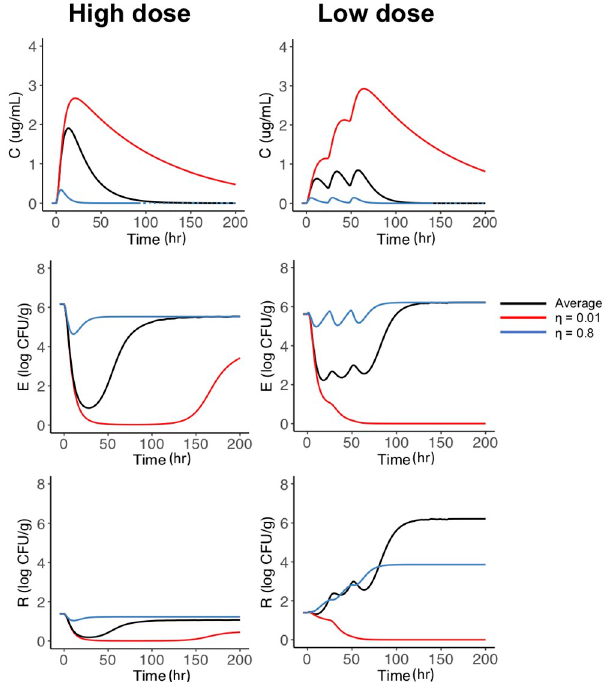
Fig 9. Variations in η . Varying η , the elimination of the drug from the colon, to understand the changes that occur in sick or non-normal steers in the low and high dose study. The black line represents the average steer simulation, the red line is slow movement ( η = 0.01) and the blue line is rapid movement ( η = 0.8).